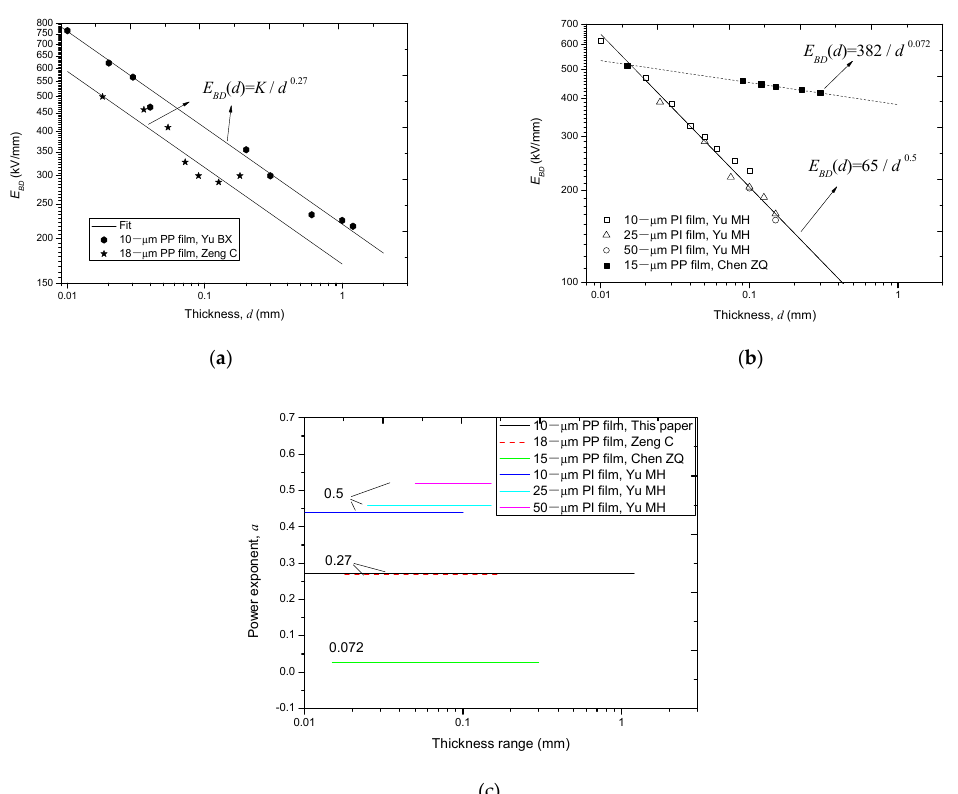
Figure 5. Re-plot and fit different groups of E BD - d data in log-log coordinate systems. ( a ) Moderate tendency of E BD - d data; ( b ) fast and slow tendency of E BD - d data; ( c ) comparison of the power exponent of the thickness effect in a wide thickness range.